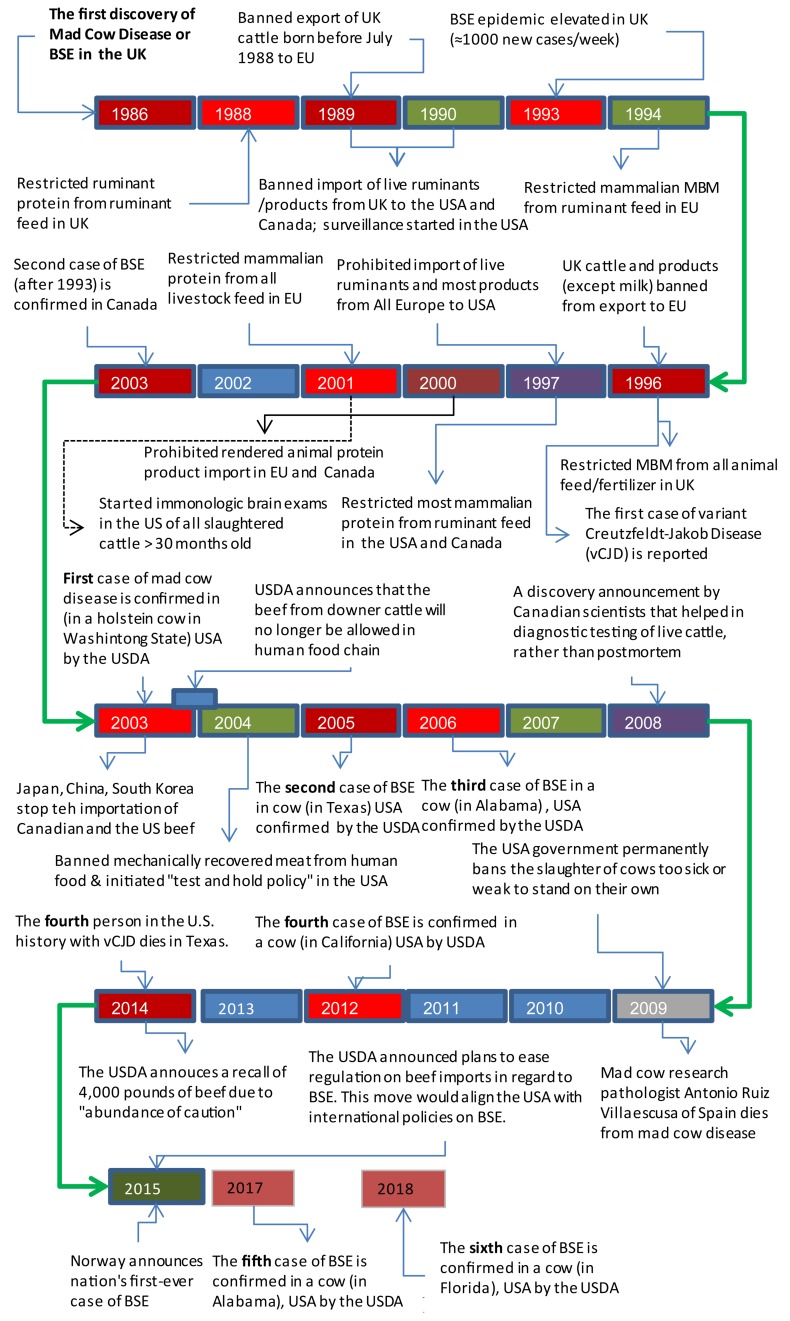
Time line and cases of BSE in the US, Canada, and the UK.